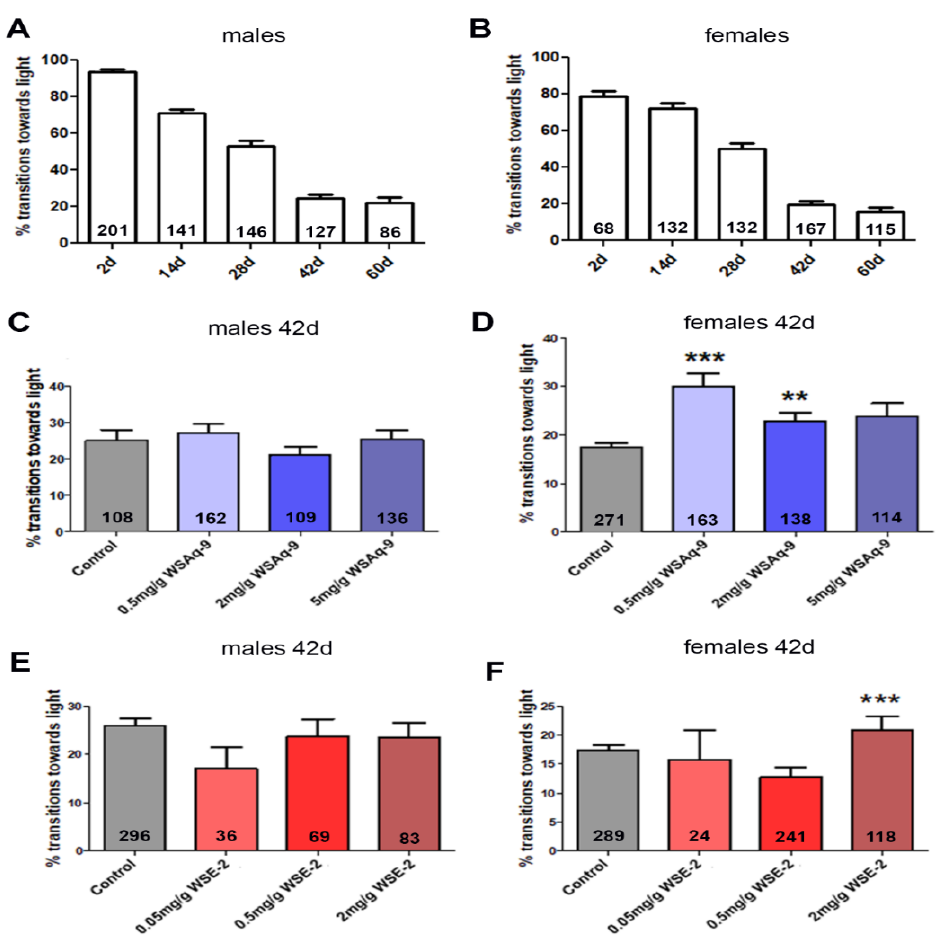
Figure 3. Performance in the phototaxis assay declines in males ( A ) and females ( B ) with age. ( C ) WSAq-9 does not improve the performance in males at any concentration tested. ( D ) Performance is improved in females fed with food supplemented with 0.5 mg/g and 2.0 mg/g WSAq-9. ( E ) WSE-2 does not increase the phototaxis response in males at any of the concentrations tested. ( F ) Females perform better when given 2.0 mg/g WSE-2. Kruskal–Wallis ANOVA with built-in Bonferroni post- hoc test was used for statistical analyses. Bars represent means and error bars SEMs. The number of tested flies is given in the bars. ** p < 0.01, *** p < 0.001 compared to controls on regular